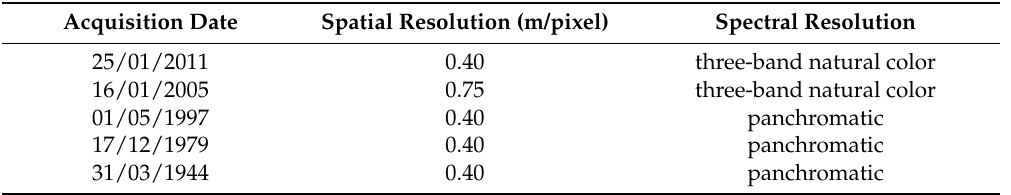
Table 1. Aerial photographs for the study area.